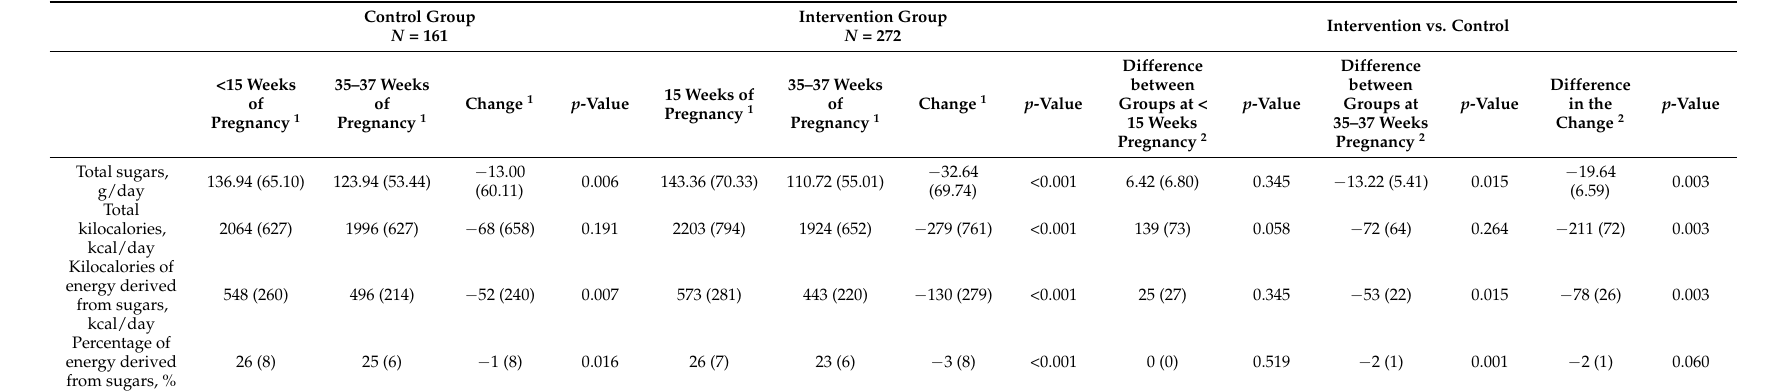
Table 2. Change in consumption of total sugars and